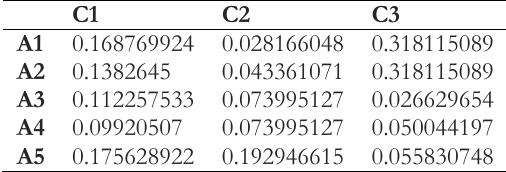
Table 7. The weighted normalized decision